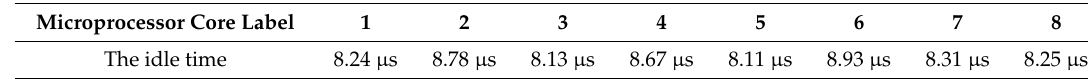
Table 2. The usage of eight microprocessor cores.